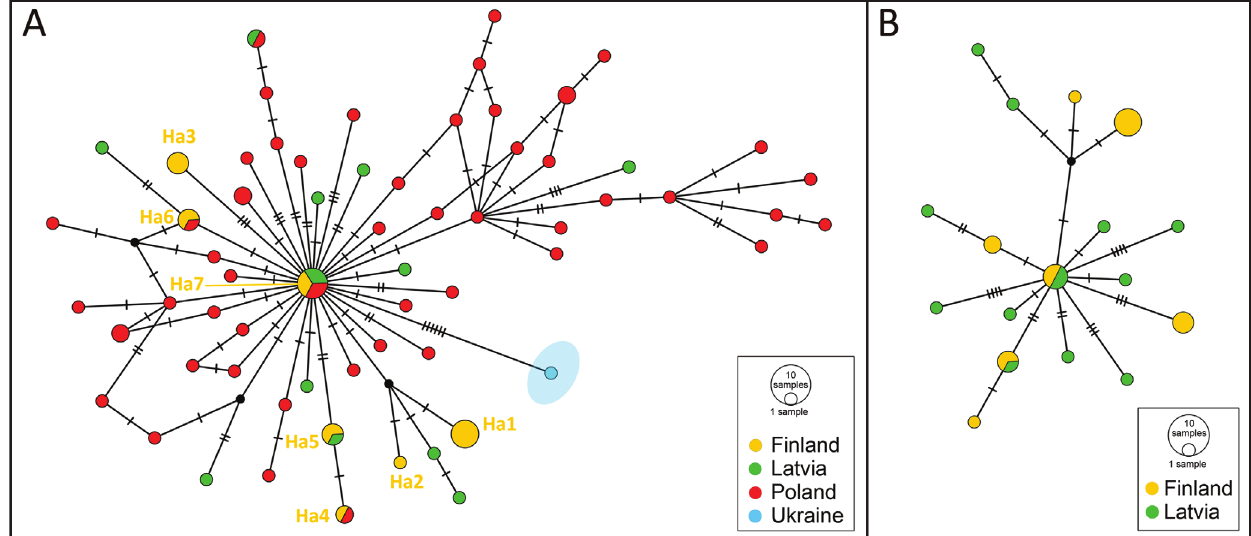
Figure 2. Haplotype network diagram based on mitochondrial cox 1 haplotypes of Spirometra erinaceieuropaei from: (A) Finland (current data), Latvia [1], Poland [7, 14], and Ukraine [14]; and (B) speci fi cally for Finland and Latvia. The sizes of haplotypes are proportional to the number of samples. Codes denote haplotype identi fi ers detected in individuals from Finland. Each hatch mark represents a single mutation, while black dots symbolise intermediate missing or unsampled